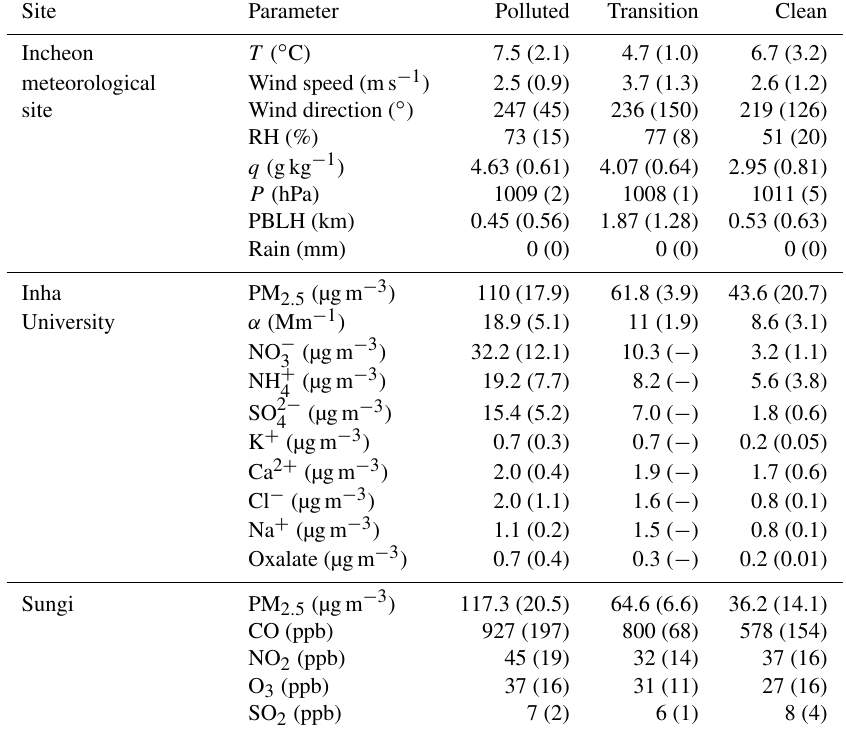
Table 3. Average Incheon meteorological, aerosol, and gas parameters for the polluted, transition, and clean time periods, with standard deviations shown in parentheses. Speciated concentrations from Inha represent mass for particles with diameters above 0.016µm (i.e., full size range of DLPI + sampler) and are weighted by sample duration when calculating the time period average; species with concentrations below their respective LOD in more than 50% of samples (see Table S1) are not shown. Standard deviations are not shown for the transition period speciated data owing to there only being one sample